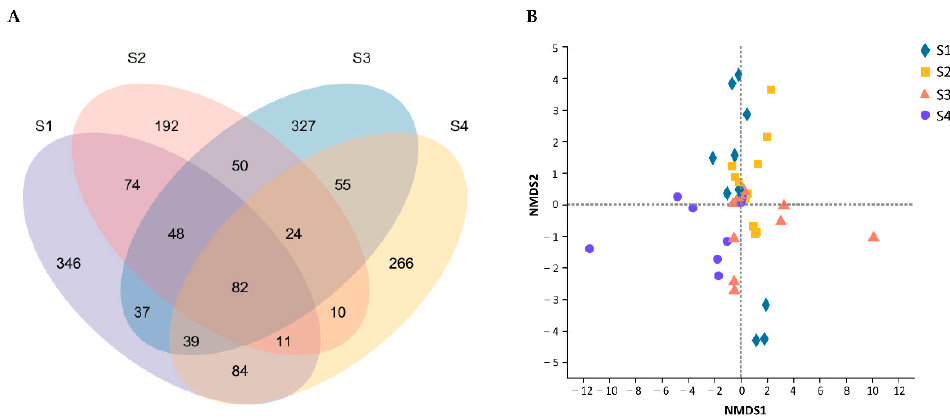
Figure 4. ( A ) Venn diagram showing number of shared and station-specific ASVs. Samples from all seasons were pooled for each station (S1–S4). ( B ) Beta diversity of four stations was examined based on binary Euclidean distance matrices using non-metric multidimensional scaling (NMDS) in R .